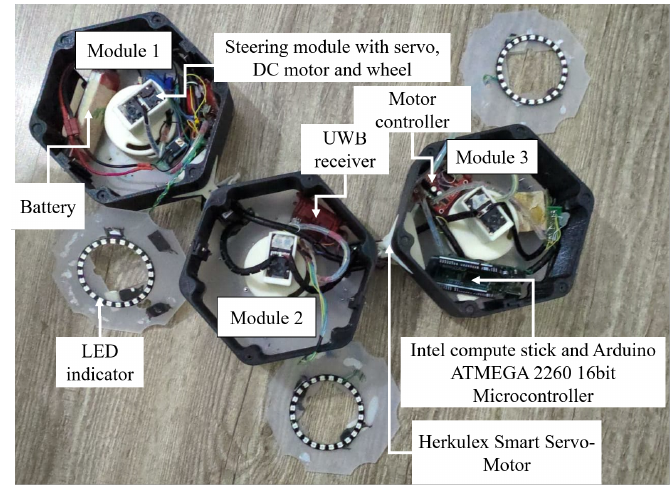
Figure 2. Electronic components of hTrihex.